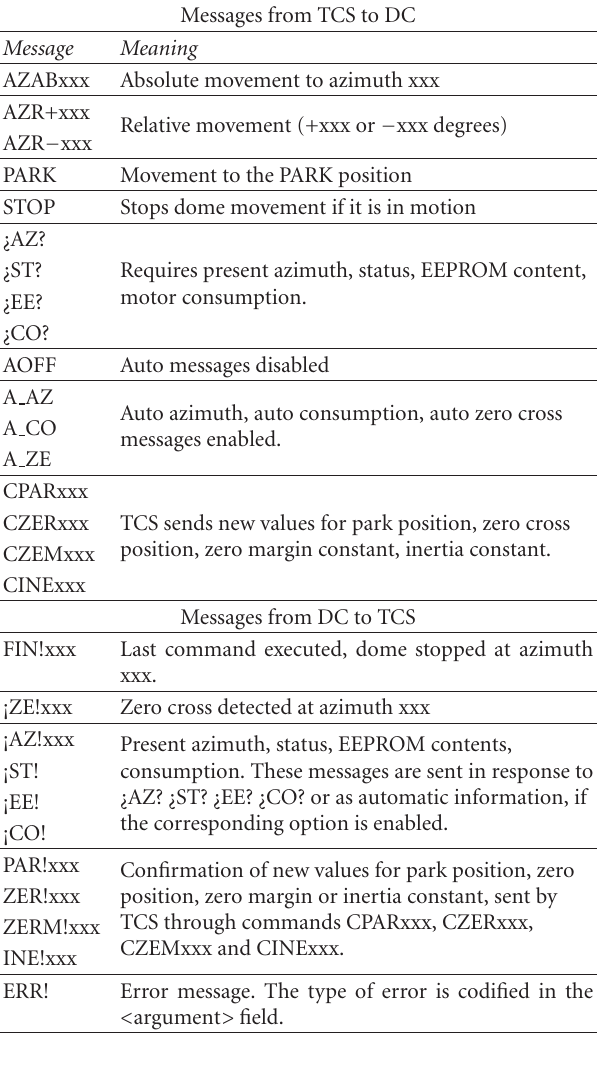
Table 2: Description of messages used in the communication between TCS and DC.